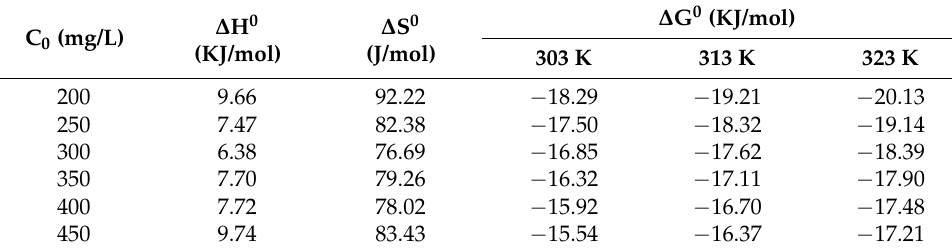
Table 9. Thermodynamic parameters for Zn 2+